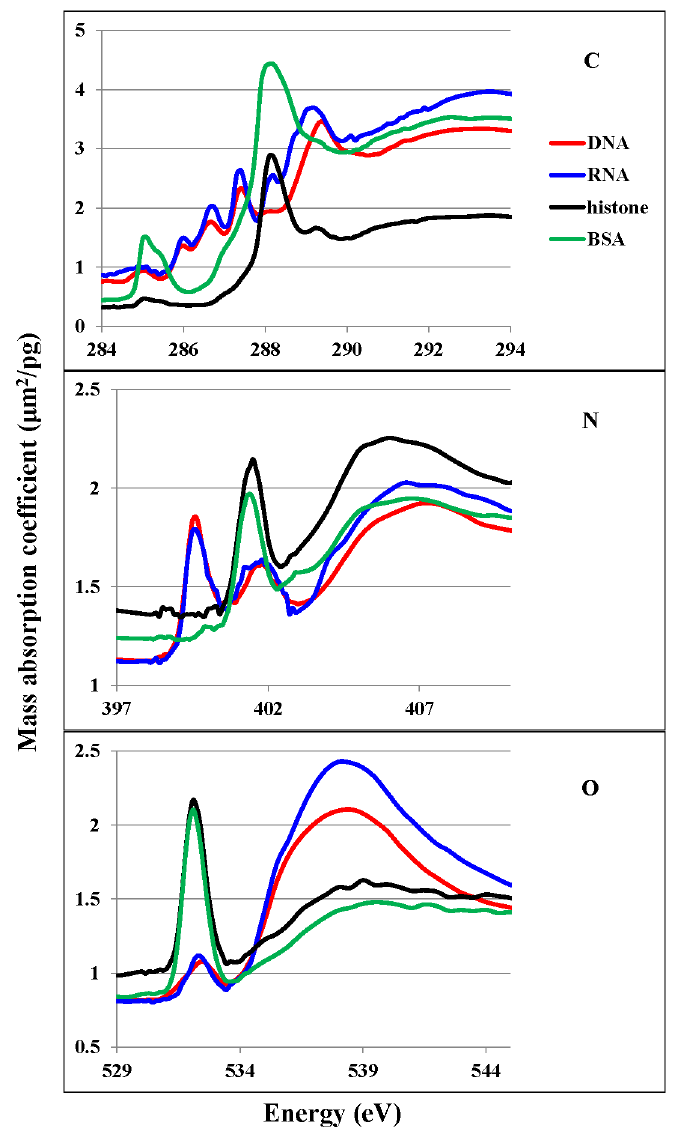
Figure 1. NEXAFS spectra of DNA (red line), RNA (blue line), histone (black line), and BSA (green line) at the carbon (C), nitrogen (N), and oxygen (O) K absorption edge